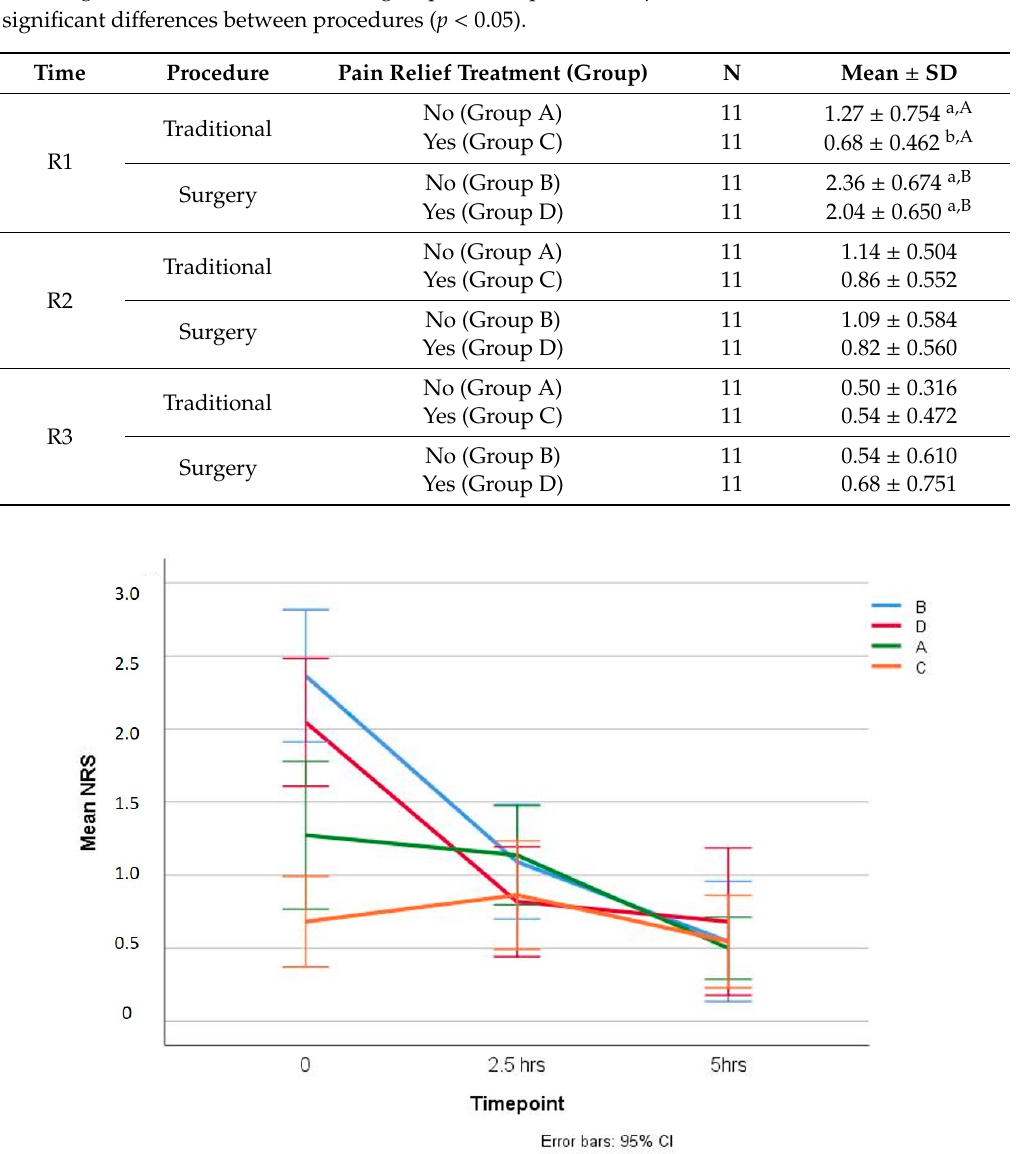
Figure 1. Mean of pain-related behaviour score (NRS) in the four Groups A, B, C, and D, shortly (R1), 2.5 h (R2) and 5 h (R3) following tail docking (Error bar: 95% CI). Groups A and C, the tail was excised with a scalpel without anaesthesia or stitches; Groups B and D, the tail was surgically excised and stitched under GA; with Groups C and D immediately sprayed with PR.